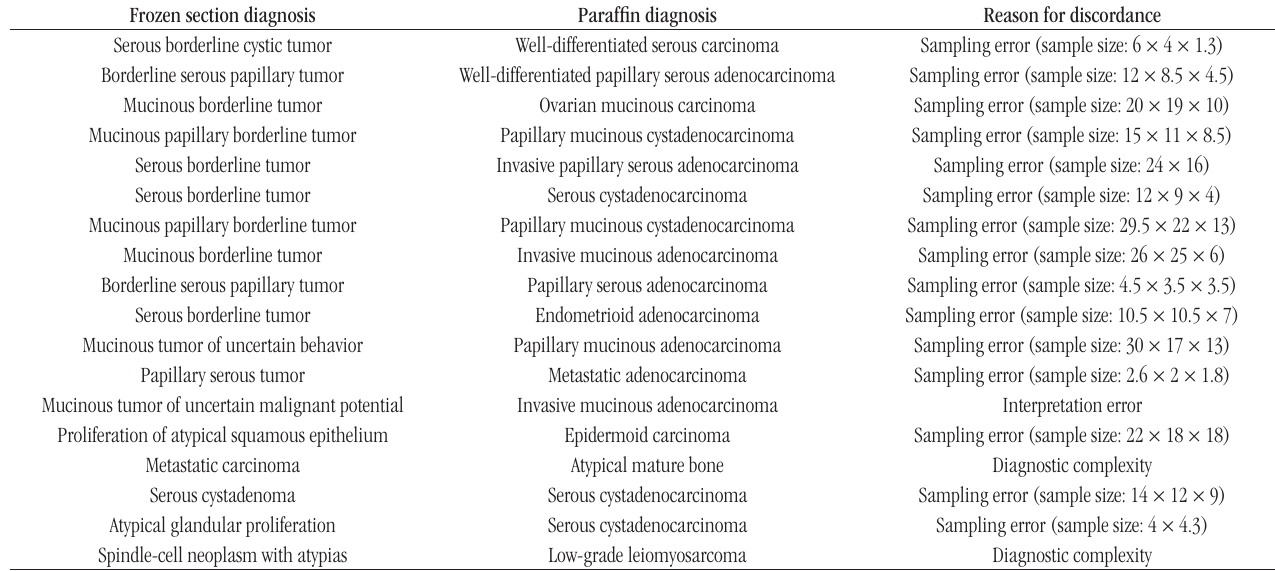
taBLE 3 − Causes of discordance found in ovary